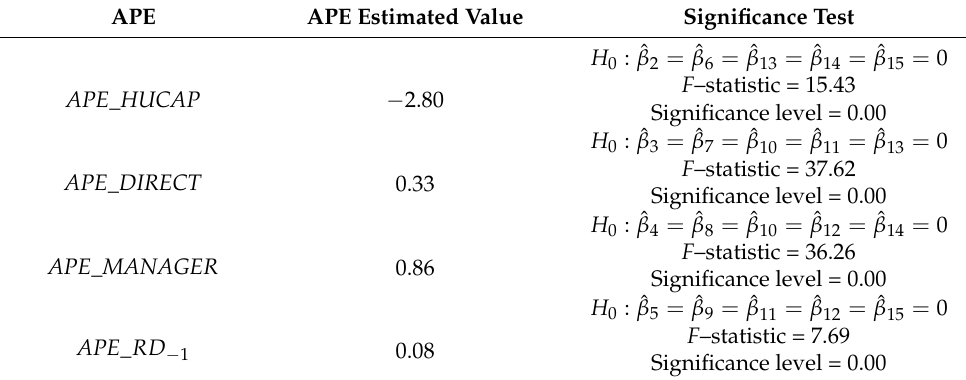
Table 6. APE of human resources and R&D expenses on revenue. APE APE Estimated